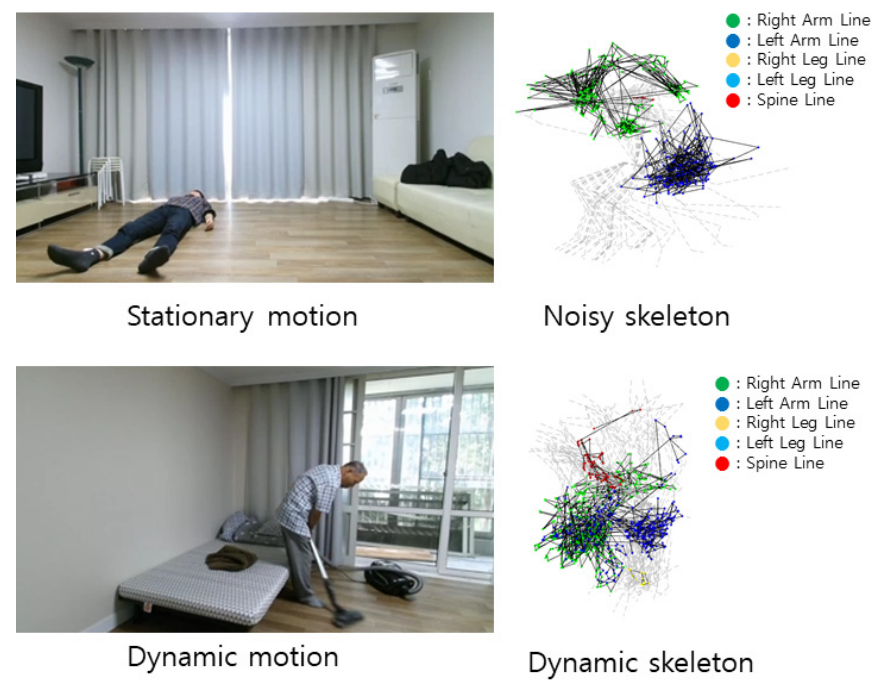
Figure 11. Example of noisy and dynamic skeletons.